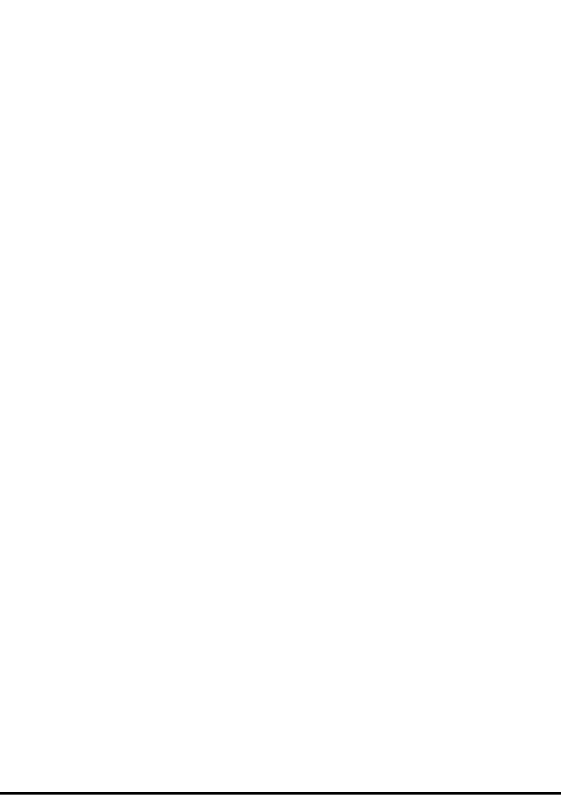
Fig.2 : Tuberculous bacilli spread to the disc space from surrounding tissues (contiguous spread) or through the vascular supply (hematogenous